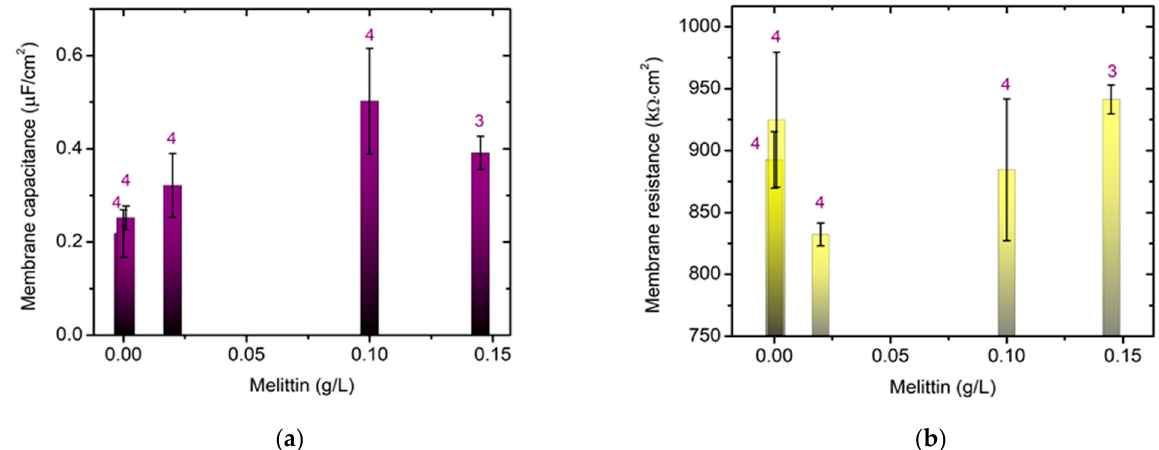
Figure 6. Membrane capacitance ( a ) and membrane resistance ( b ) of egg PC bilayers in 1.25 mM Na 2 HPO 4 /KH 2 PO 4 buffer (ionic strength of 0.003 mol/L), pH 7.4, in the presence of melittin. The membrane resistance and membrane capacitance are presented as the weighted mean ± SD; the number of independent measurements, with each of them averaged over 10 repetitions, is indicated above the bars.